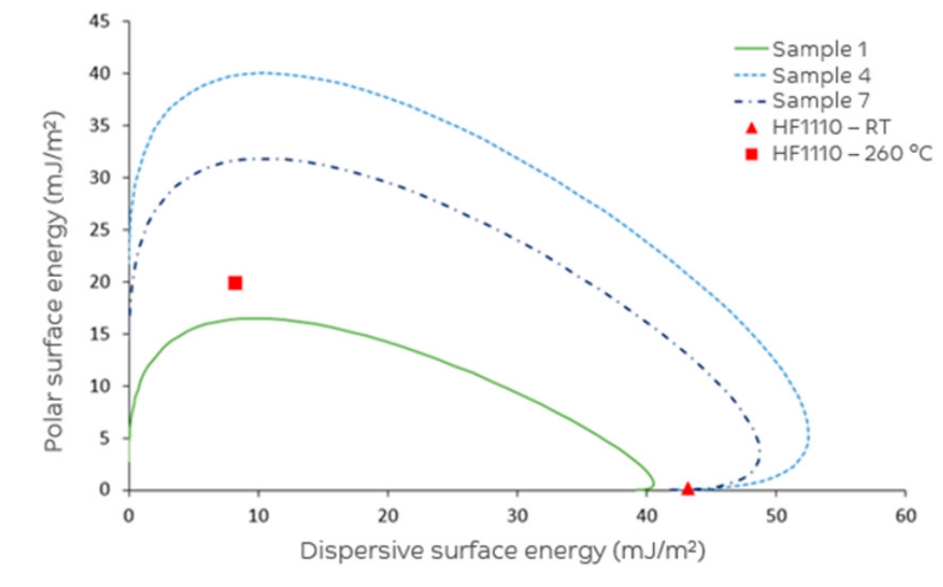
Figure 4. Wetting envelope for complete wetting ( θ a = 0 ◦ ). Table 6. Tensiometer results of the fibres produced.